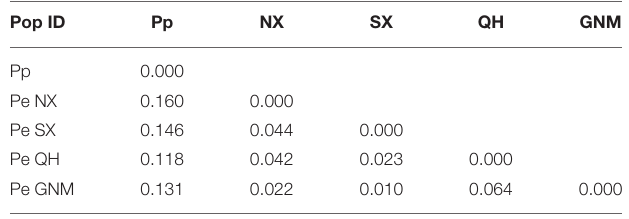
TABLE 1 | Comparison of genetic diversity among and within species. TABLE 2 | Comparison of genetic differentiation among and within